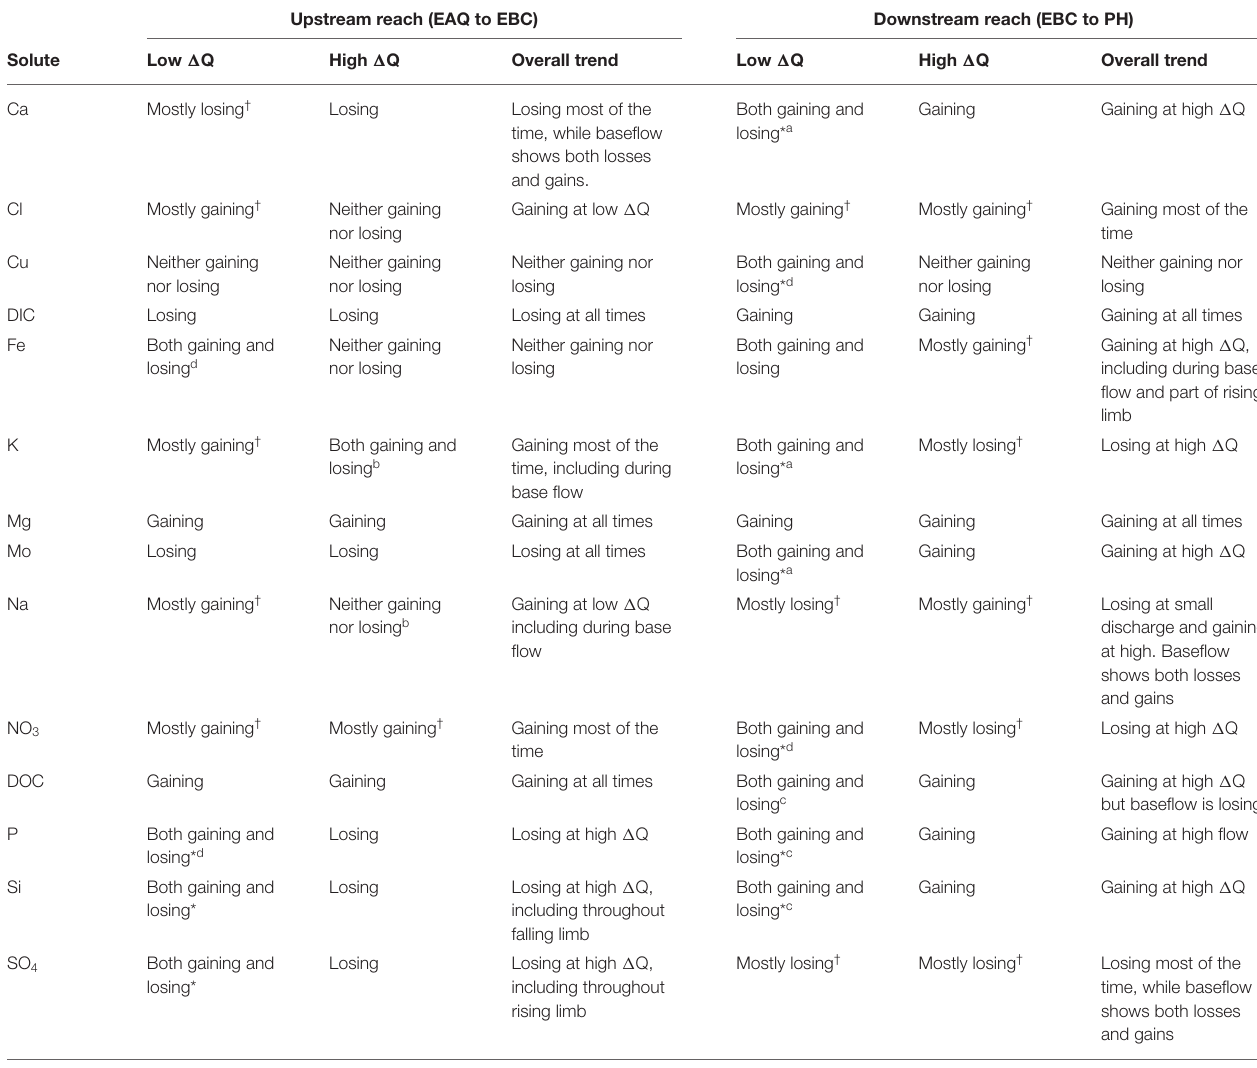
TABLE 5 | Differential concentration-discharge relationship for solutes at the upstream and downstream reaches of the East River